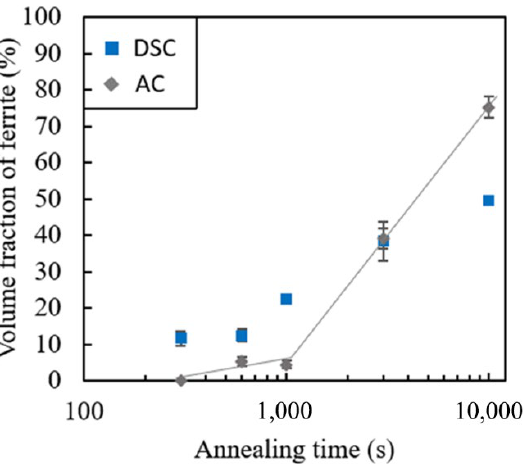
Figure 11. Ferrite volume fraction comparison between strip cast (DSC) specimens and austenite coarsen (AC) specimens with respect to annealing time.